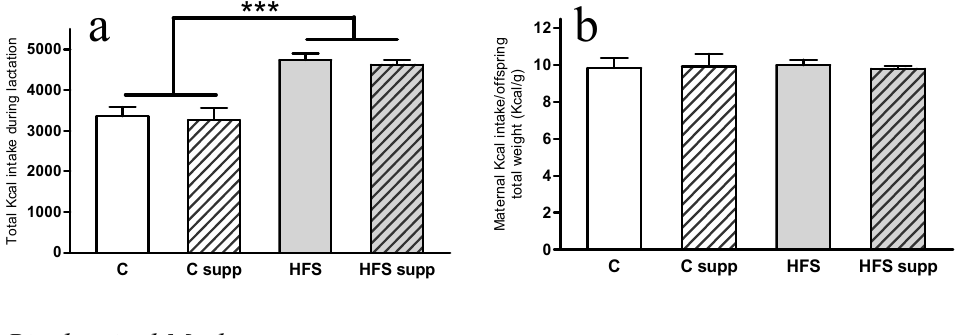
Figure 2. Maternal energy intake during lactation ( a ) and energy consumption per offspring weight ( b ). Data are reported as means ± SE ( n = 8 from each experimental group). C, control; C supp, control supplemented; HFS, high-fat-sucrose; HFS supp, high-fat-sucrose supplemented; *** p <